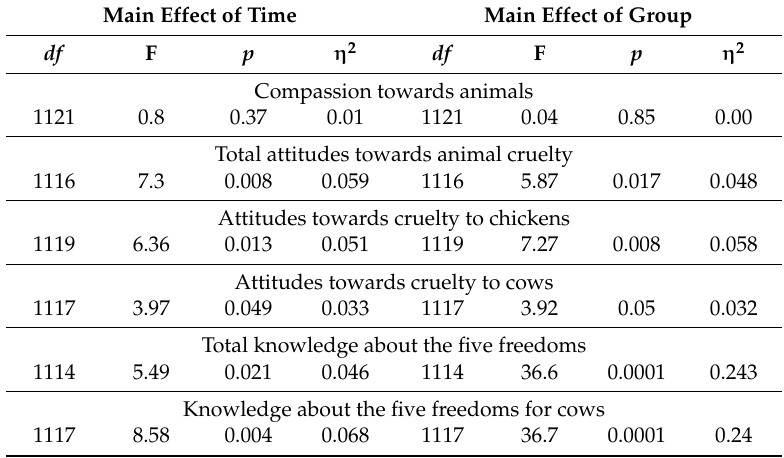
Table 2. Results from main effects analysis for each intervention, following insignificant